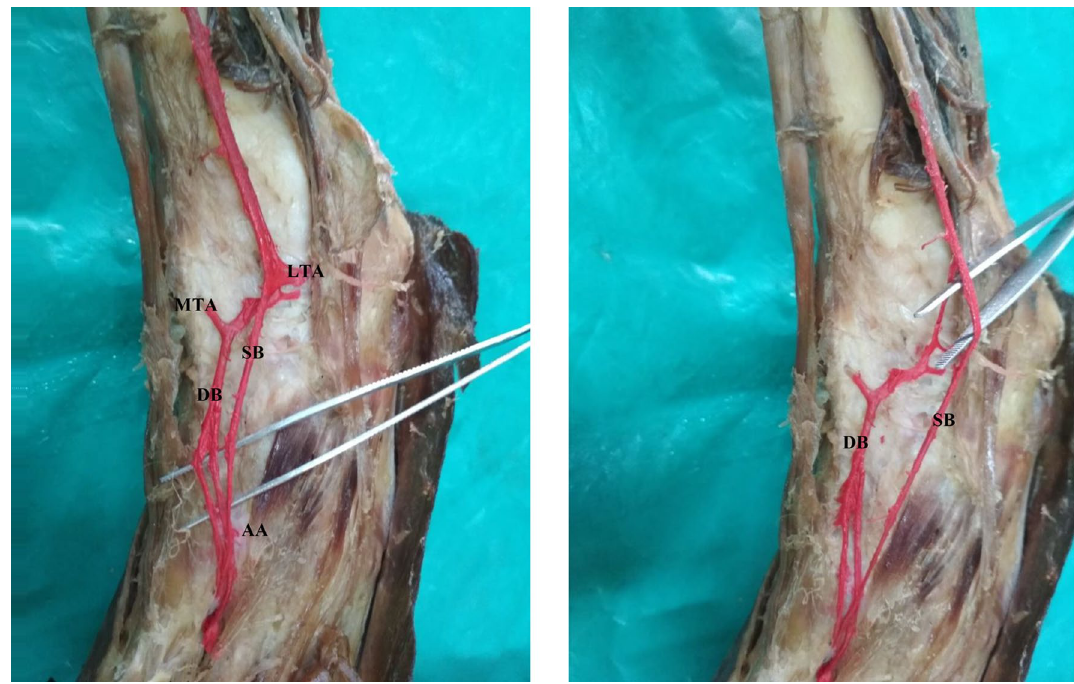
Figure 2. Showing double dorsalis pedis artery. SB-superficial branch, DB-deep branch, LTA-lateral tarsal arteries, MTA-medial tarsal artery, AA-arcuate artery.